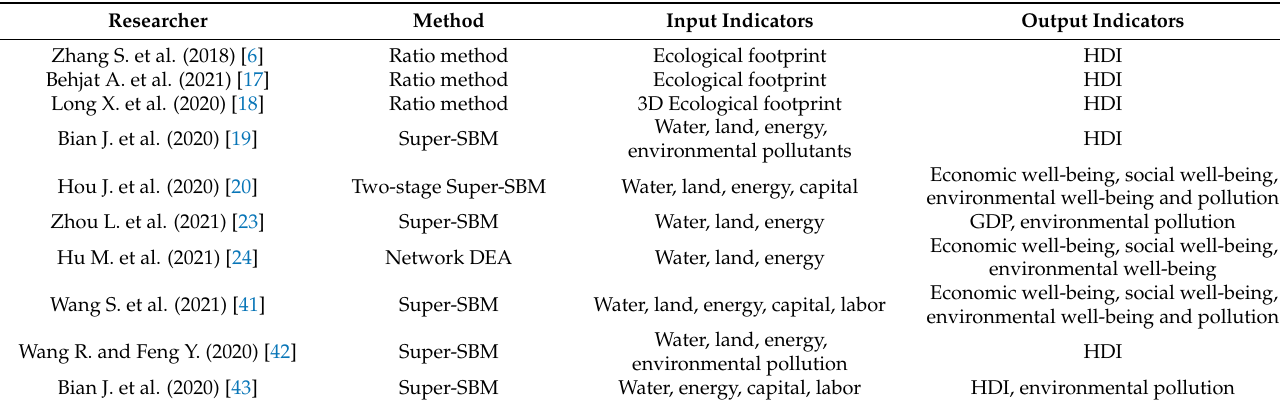
Table 1. Studies related to ecological well-being performance.